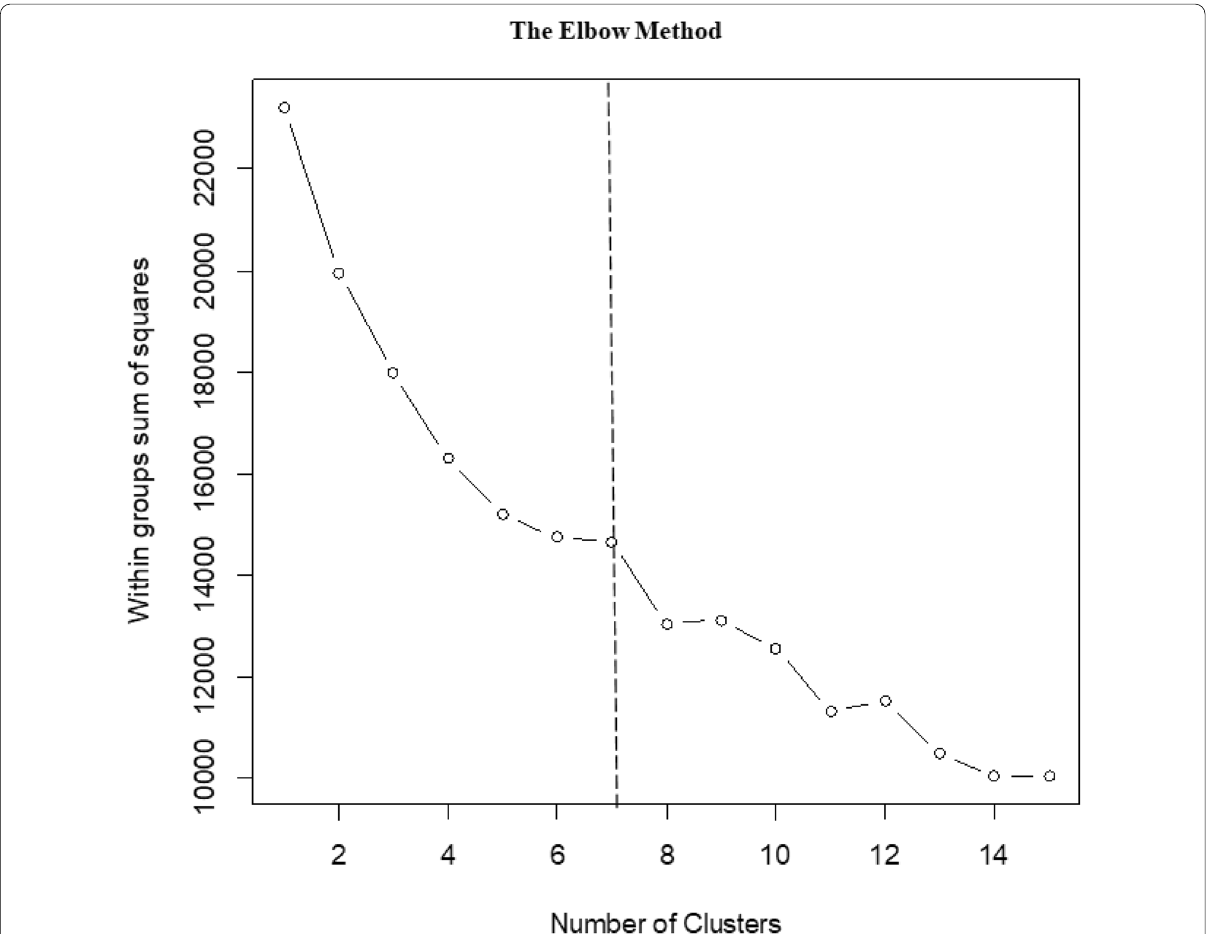
Fig. 5 Determination of optimal number of clusters corresponding to plant community types in Sele-Nono forest (Diagram of the Elbow method shows the expected optimal number of clusters. Within group (Cluster) Sum of Squares values represent the sum of squared Euclidean distances between the plots and the centroid. The Elbow is the first breaking point, seen after the flattening of the curve, in our case,